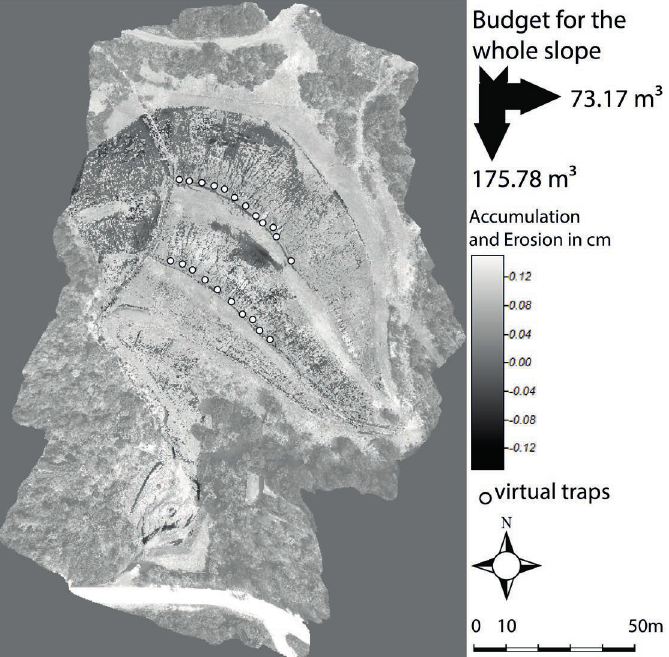
Fig. 3 Erosion and accumulation estimates for the Rio Marina study site from Sept. 2009 to April 2012. The arrows indicate the amount of material deposited on the slope and transported out of the area. “Virtual traps” are represented by